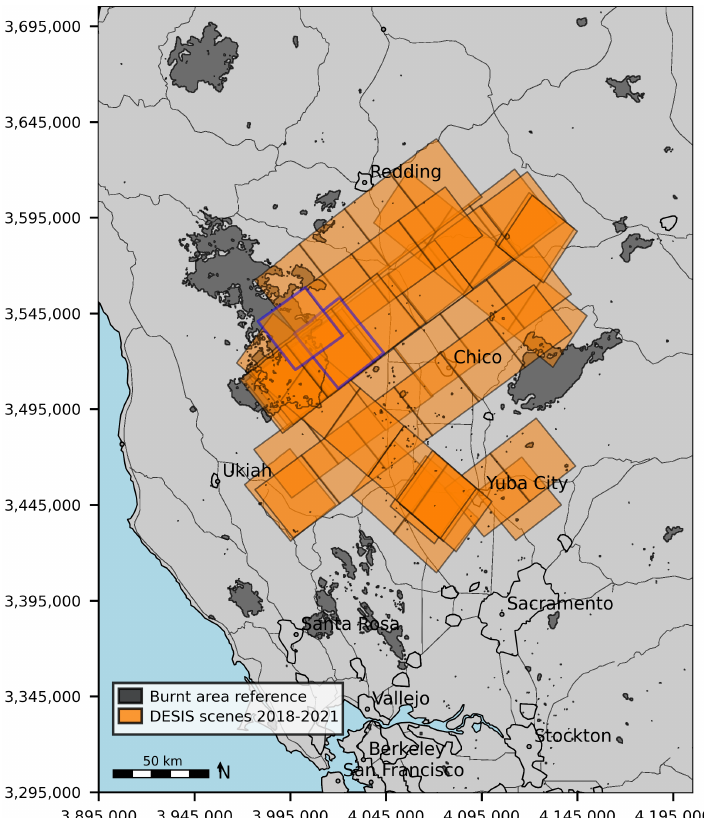
Figure 2. Area of Interest: Northern California. The footprints of available DESIS scenes are shown in orange. Burnt area reference perimeters, derived from Sentinel-3 OLCI data, are depicted in dark gray. The footprints with blue contours depict the region exemplary visualized in Figure 3.